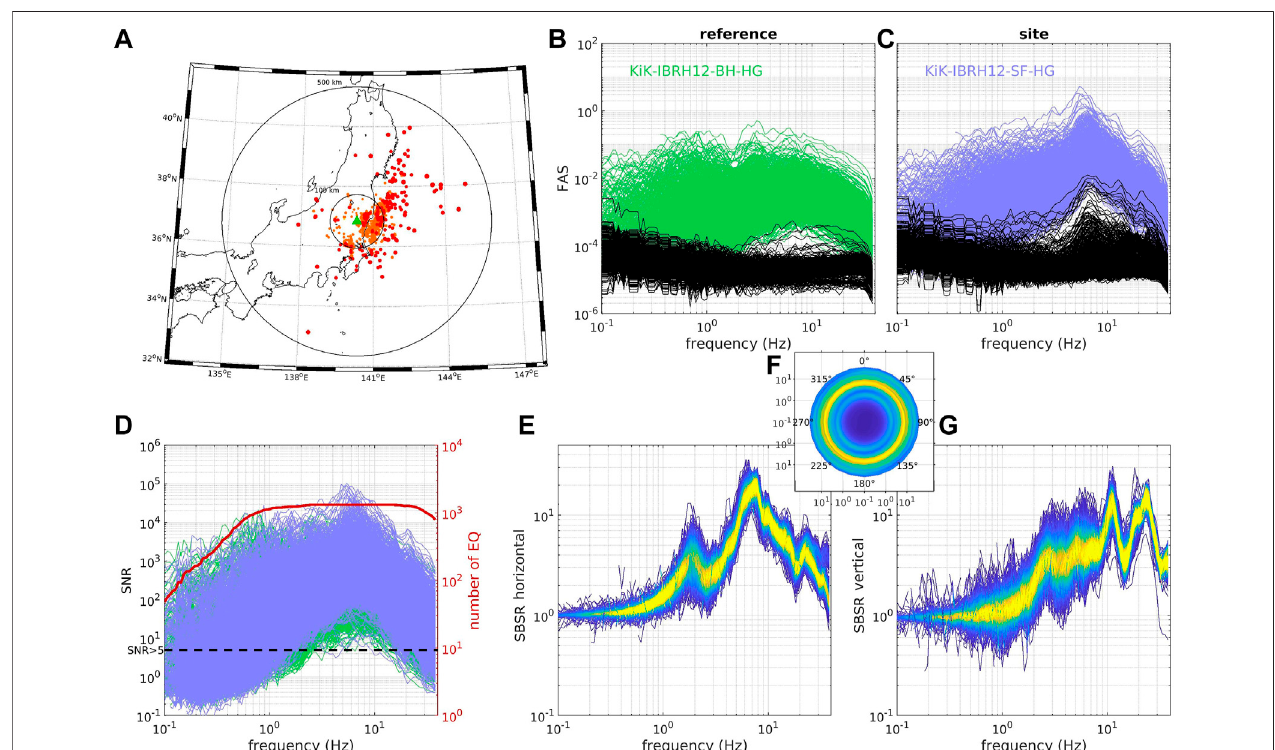
FIGURE 1 | Example of the surface-to-borehole spectral ratio (SBSR) computation at KiKnet station IBRH12 in Japan. (A) The map shows the location of the site (greentriangle)andtheepicentersoftheselectedearthquakes(yellow-to-reddotaccordingtotheearthquakemagnitude).Panels (B) and (C) presentthepowerspectral density(PSD)forthenoise(blacklines)andfortheearthquakerecordingonthehorizontalmeancomponentatthesite(bluelines)andatthereference(greenlines).Panel (D) indicatestheSNRatthesite(bluelines)andatthereference(greenlines),aswellasthenumberofearthquakesspectrumwithSNR > 5(redline)asafunctionof frequency. The distribution of the SBSR as a function of frequency for the horizontal mean component (E) , for the horizontal as a function of the azimuth (F), and for the vertical (G) component. The color scale indicates the density of lines, each line corresponding to the SBSR of one single earthquake.